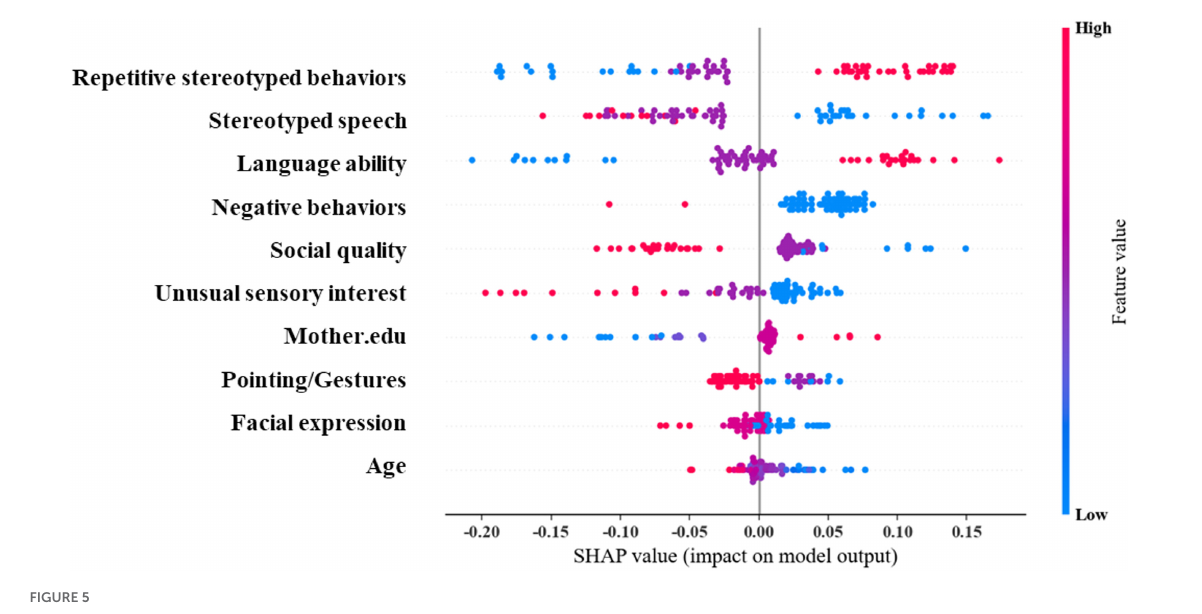
FIGURE5 SHAP value and importance of each feature in